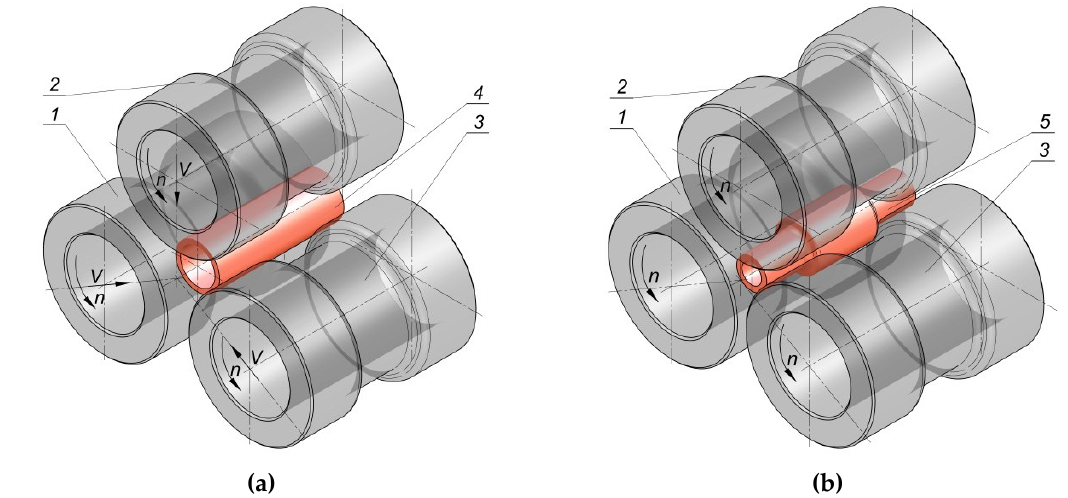
Figure 4. Scheme of rotational compression of a hollow forging of an elementary shaft: ( a ) beginning of the process; ( b ) end of the process, 1,2,3—forming rolls, 4—billet in the form of a section of a tube, 5—finished product.